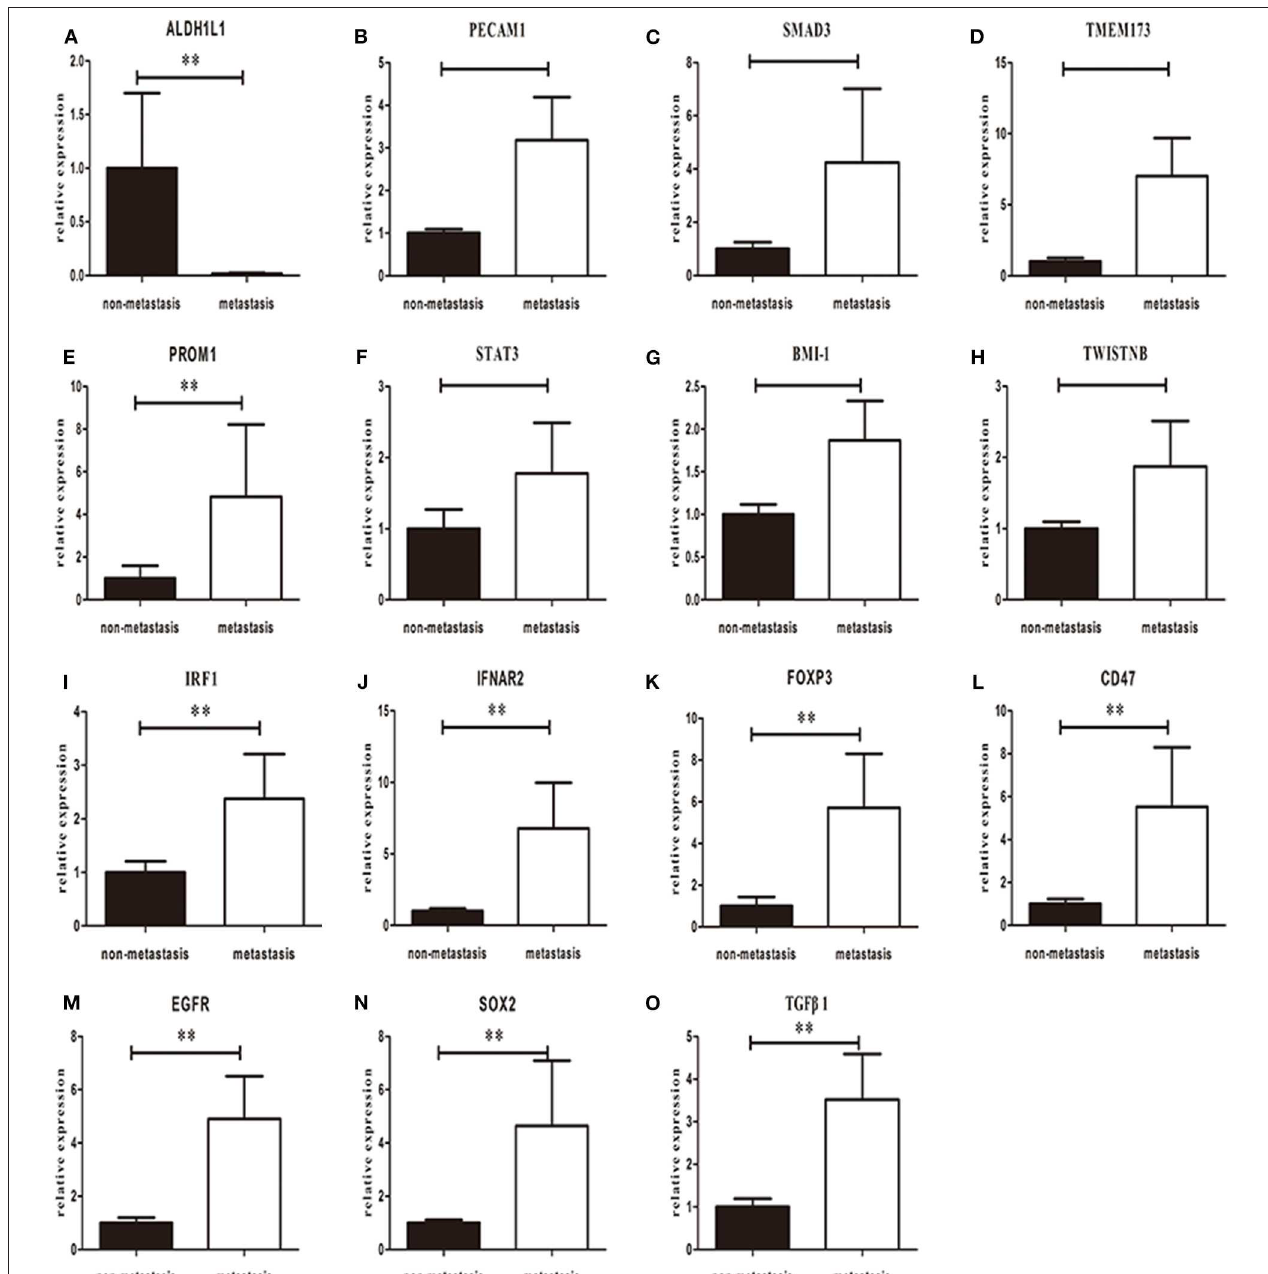
FIGURE 4 | Overall mean-normalized mRNA expression of ALDH1L1 (A) , PECAM1 (B) , SMAD3 (C) , TMEM173 (D) , PROM1 (E) , STAT3 (F) , BMI-1 (G) , TWISTNB (H) , IRF1 (I) , IFNAR2 (J) , FOXP3 (K) , CD47 (L) , EGFR (M) , SOX2 (N) , and TGF β 1 (O) in lymph nodes. Each bar represents the average log2 gene mRNA expression level of the non-metastatic and metastatic lymph nodes. P -values are calculated by Wilcoxon rank-sum test. (** p <